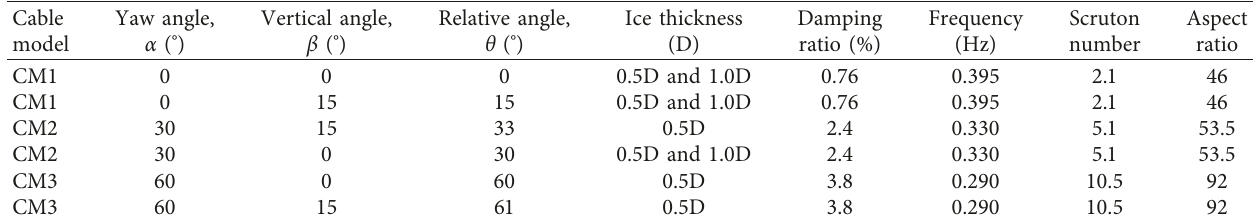
Table 1: Characteristics of the tested cable